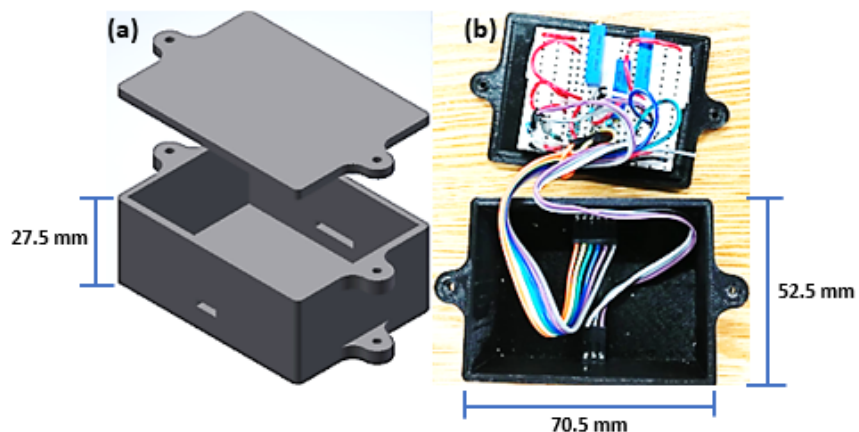
Figure 7. ( a ) Exploded isometric view of computer-aided design (CAD). ( b ) Prototype with all the signal-conditioning elements.